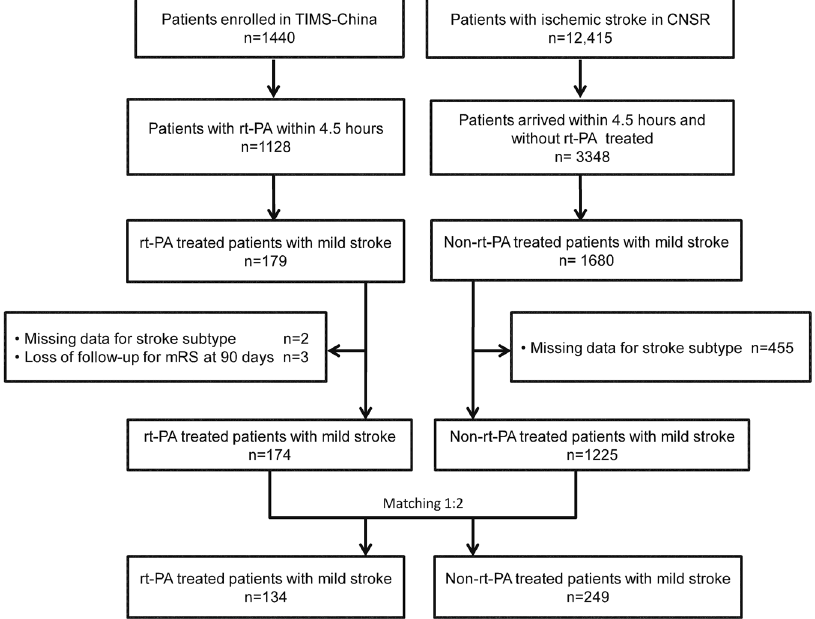
Figure 1. The flowchart of the TIMS-China and the CNSR cohorts. TIMS-China: Thrombolysis Implementation and Monitor of Acute Ischemic Stroke in China; CNSR: China National Stroke